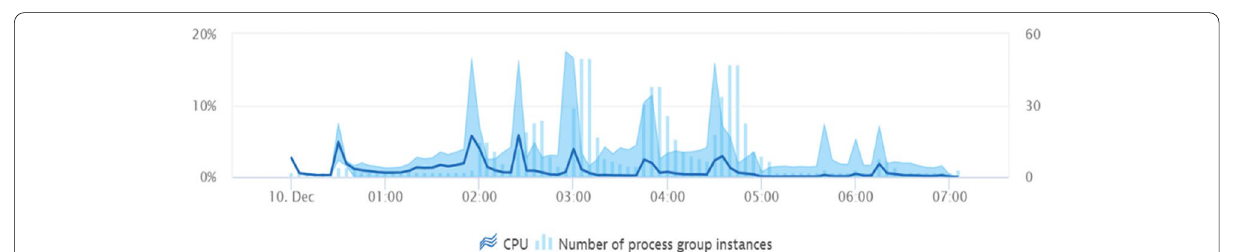
Fig. 20 Average CPU utilization of EasyTravel Frontend all instances